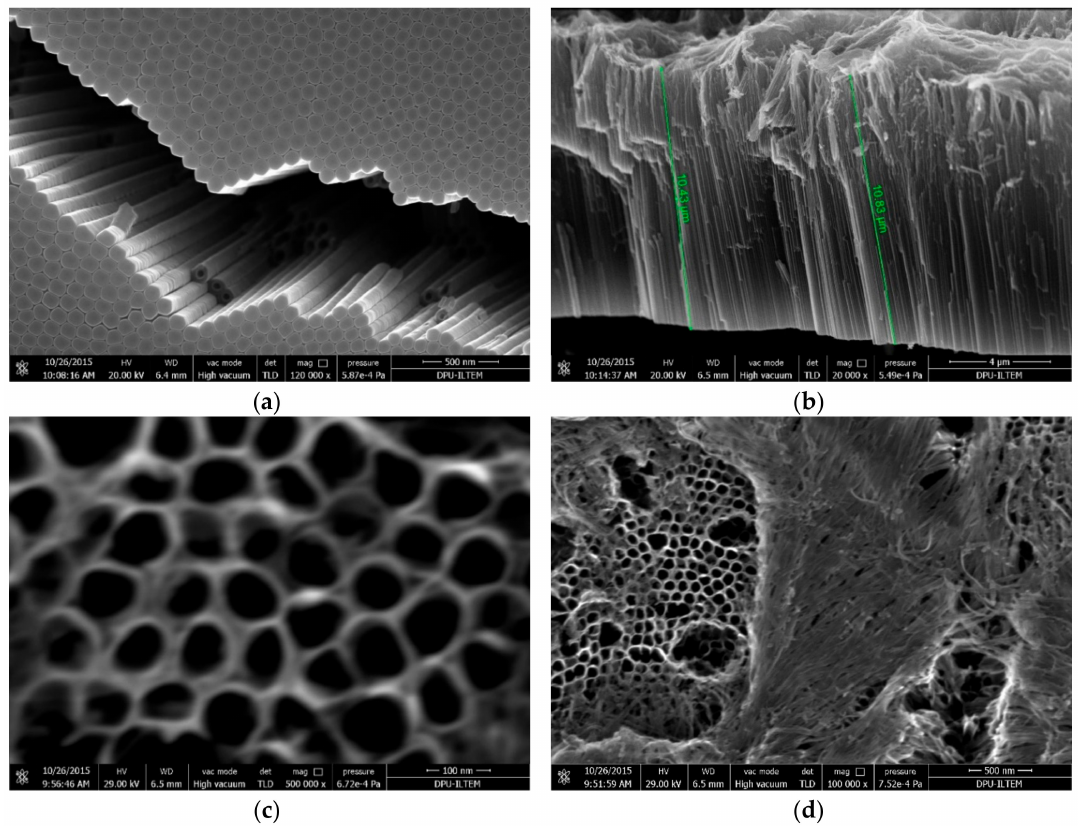
Figure 8. SEM images of Ti/TiO 2 NTEG-6h-500 photoanode: ( a ) bottom view (magnification: 120,000 × ); ( b ) cross–section view (magnification: 20,000 × ); ( c ) top view (magnification: 500,000 × ); and ( d ) top view (magnification: 100,000 × ).